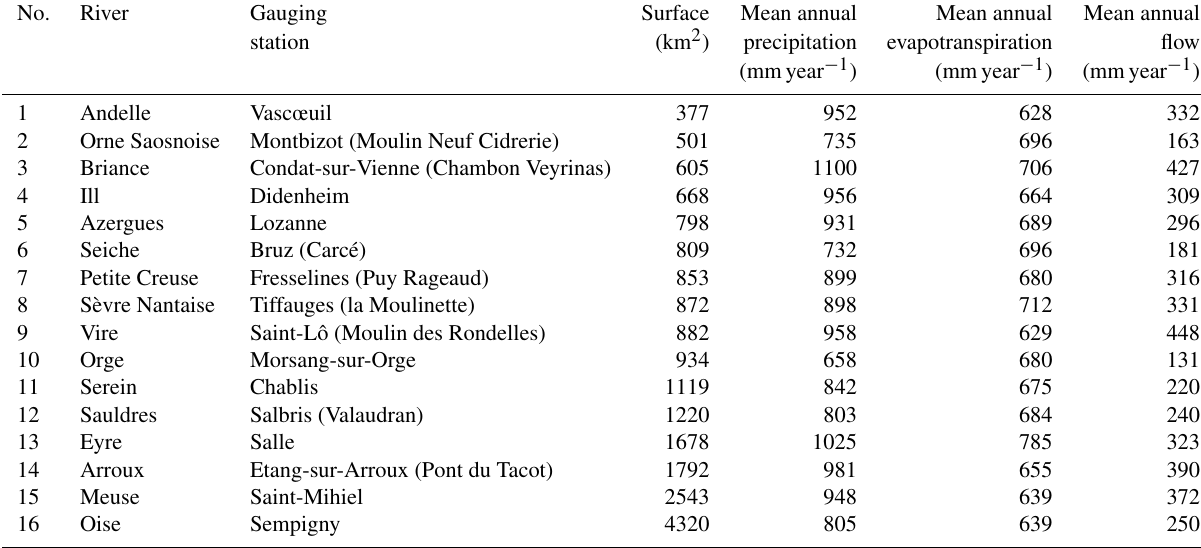
Table 1. Number, name, surface and mean annual precipitation, potential evapotranspiration and streamflow for the studied catchments.